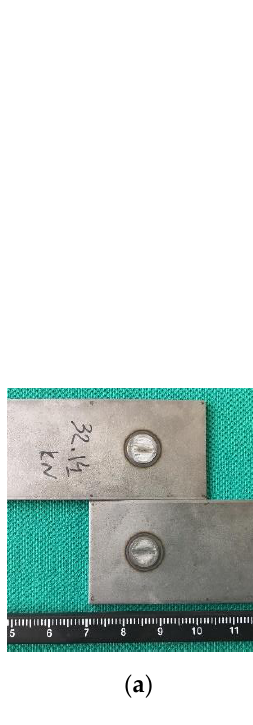
Figure 7. Tensile shear failure loads of welded joint for ( a ) uncoated hot-stamped Usibor1500 and ( b ) Al-Si coated hot- stamped Usibor1500.